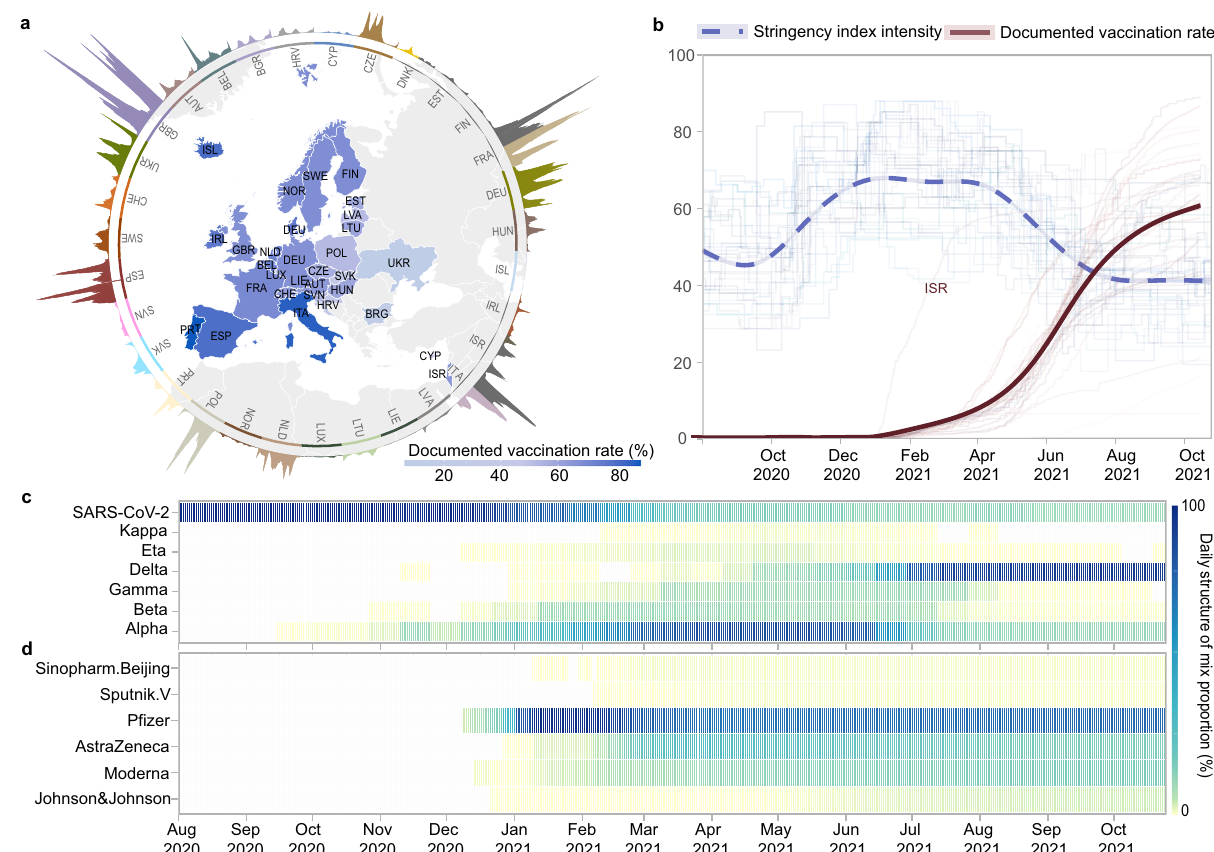
Fig. 1 Overview of the data context in 31 countries from 1 August 2020 to 25 October 2021. a Daily con fi rmed cases (outside the circle) and documented vaccination rates (inside the circle). b The stringency index of ‘ lockdown ’ style NPIs (shallow blue lines) and the documented vaccination rate (shallow red lines) across 31 countries. The documented vaccination rate refers to the proportion of the total population who were fully vaccinated in each country. The corresponding curves (thick blue and red lines) were fi tted by the locally weighted smoothing method using national data, representing overall NPIs and vaccination rate in Europe (including Israel). c Daily proportion of infections caused by SARS-CoV-2 and its variants, and ( d ) daily proportion of different COVID-19 vaccine products used, where the values of each indicator within each day add up to 1. c , d share the same right colour